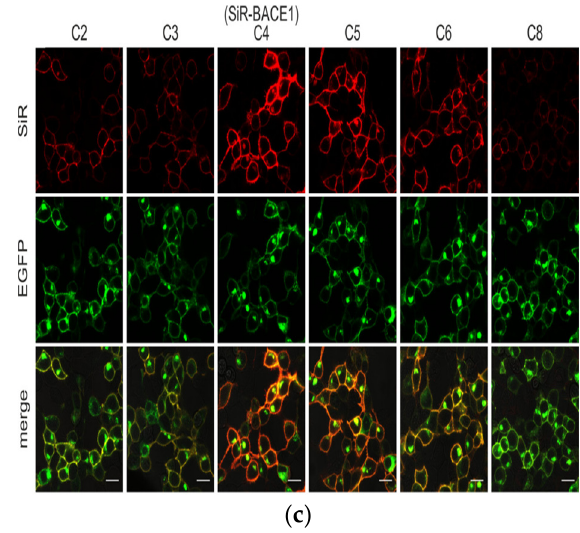
Figure 1. Si-based probe for the imaging of BACE1: ( a ) The activation mechanism of the probe; ( b ) the structure of the probe SiR-BACE1 and its analogues; ( c ) BACE1-EGFP transiently transfected HEK293T cells, stained with conjugates with different linker lengths (C2–C6, C8). Adapted with permission from [92]. Copyright (2018) American Chemical Society.